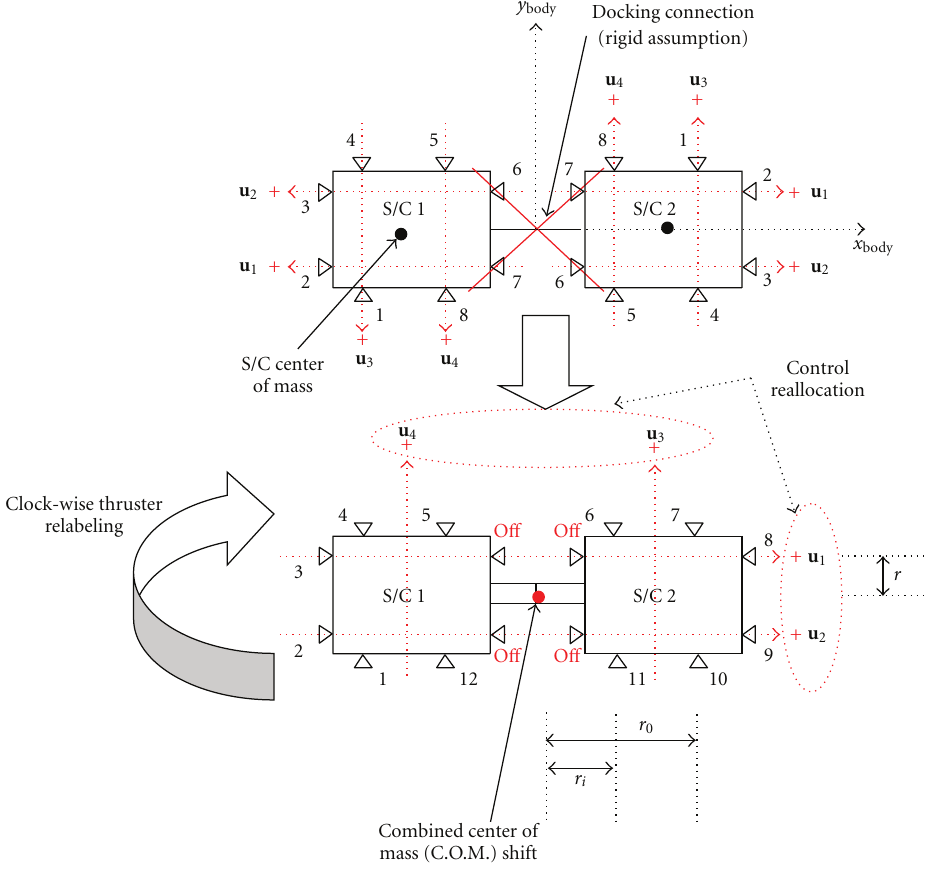
Figure 12: Assembled configurations with reallocated thruster coupling and COM shift.